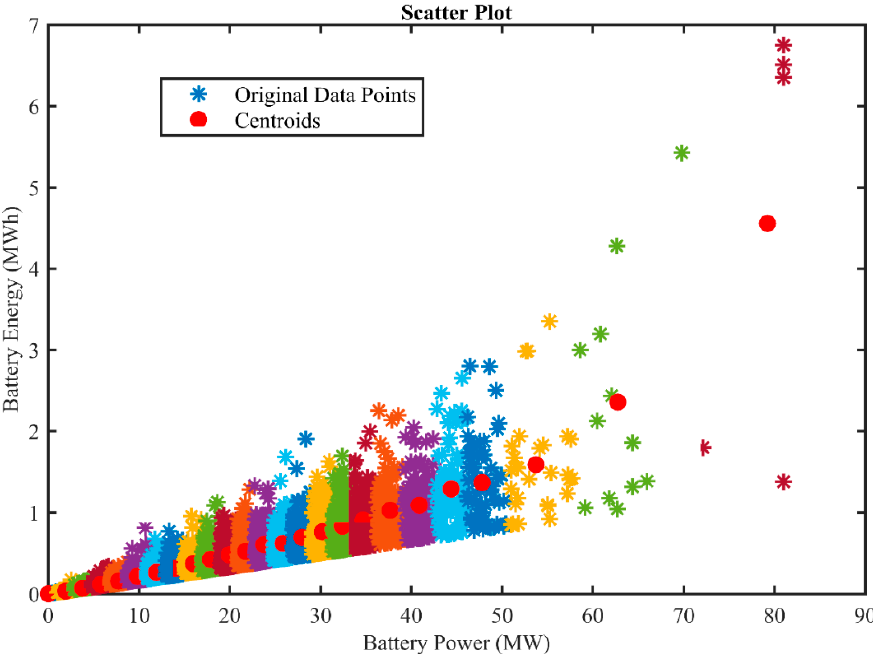
Figure 6. DST-based clustering and centroid generation for the case of 25 clusters.